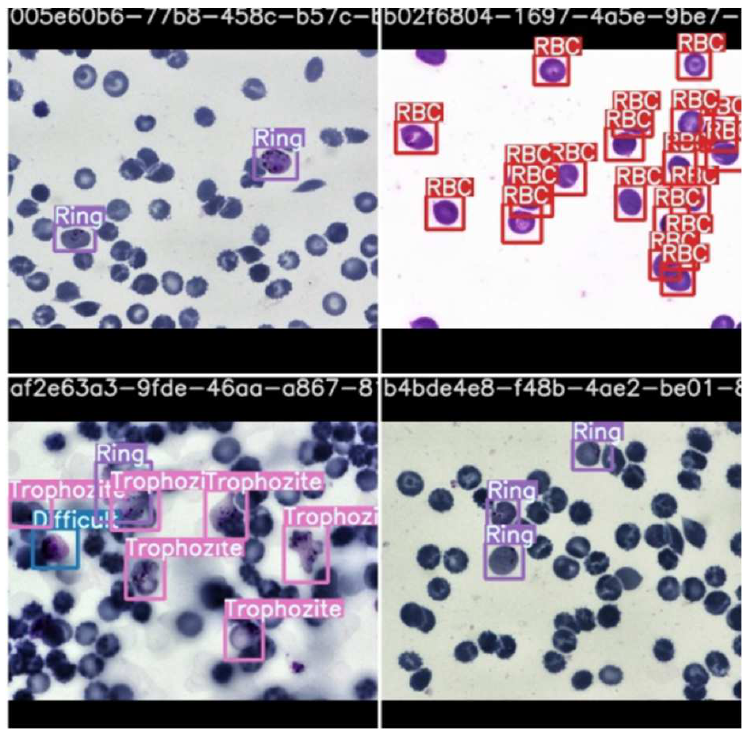
Figure 11. Stage classification prediction testing by scaled YOLOv4.